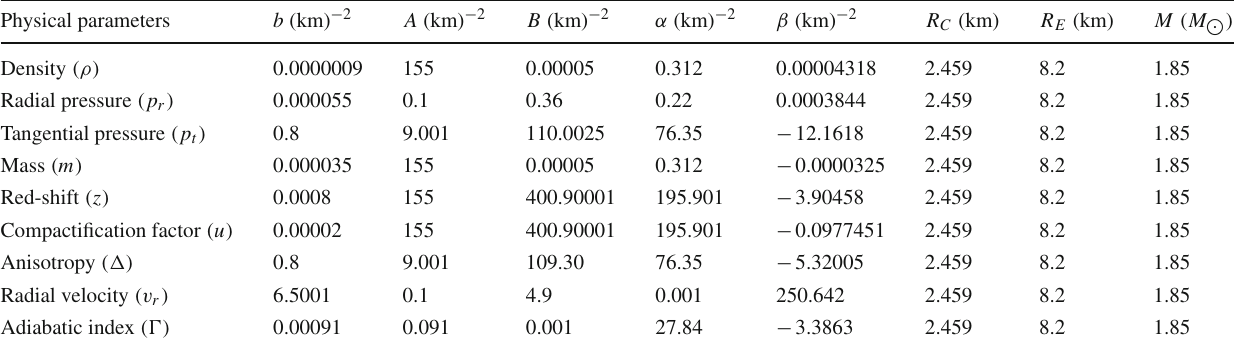
Table 2 Calculated values of constants that give core radii ( R C , masses and envelope radii R E ) for 4 U 1608 − 52 Physical